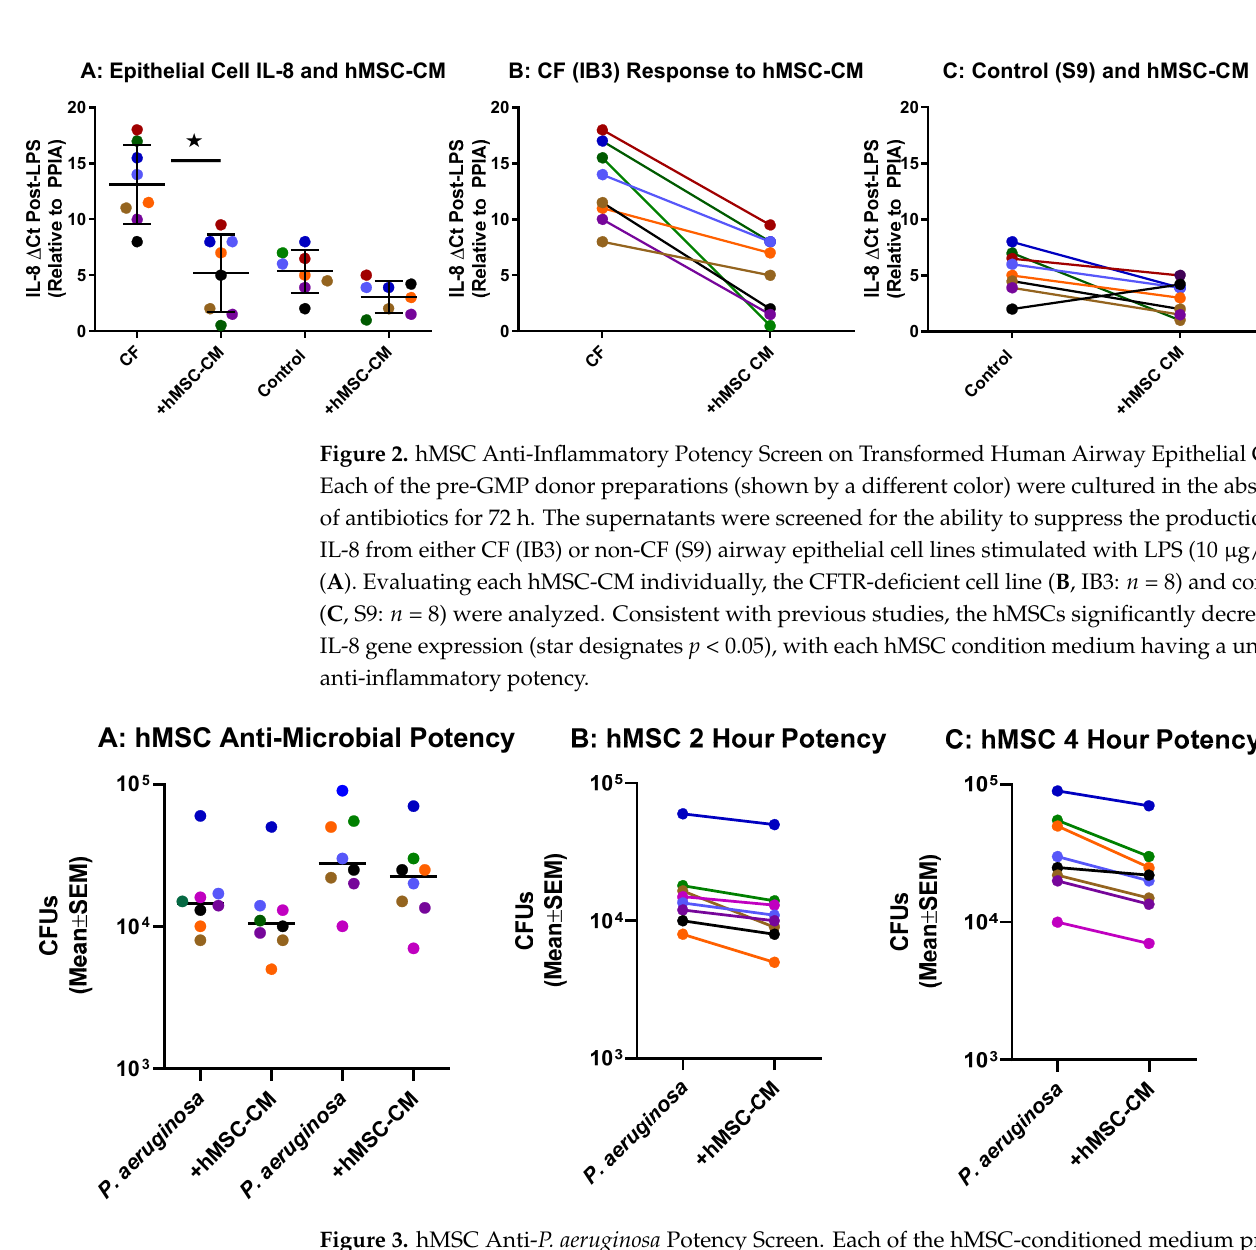
Figure 3. hMSC Anti- P. aeruginosa Potency Screen. Each of the hMSC-conditioned medium prepa- rations generated without antibiotics were analyzed for antimicrobial potency against Pseudomonas aeruginosa . The hMSC-conditioned medium from each of the donors (shown by a different color) had antimicrobial potency ( A ). When each hMSC-conditioned medium preparations were analyzed individually for antimicrobial potency measuring CFUs at 2 h ( B , n = 8) and 4 h ( C , n = 8). LPS-induced LL-37 concentration versus the antimicrobial potency at 4 h had an r = 0.67, p = 0.07 ( n =